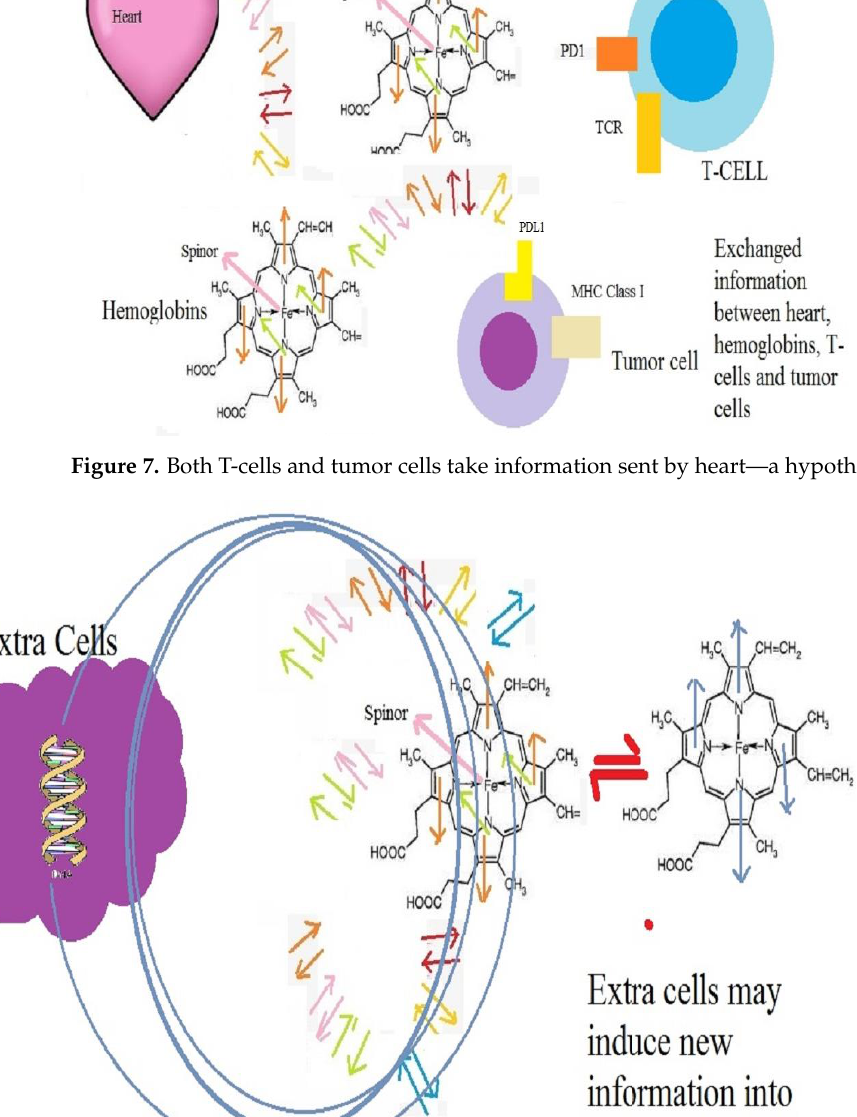
Figure 8. Extra cells could induce noise into hemoglobin—a hypothesis.